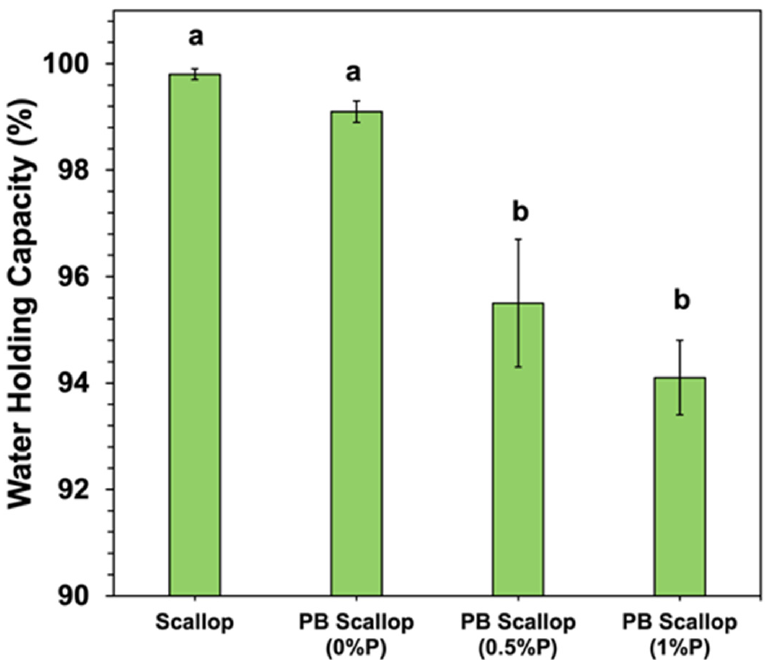
Figure 5. Water holding capacity of scallops and scallop analogs containing different pectin concentra- tions. All scallop analogs contained 10% pea protein and 2% transglutaminase. Error bars represent the standard errors ( n = 3), and similar letters mean no statistical difference between treatments ( p ≤